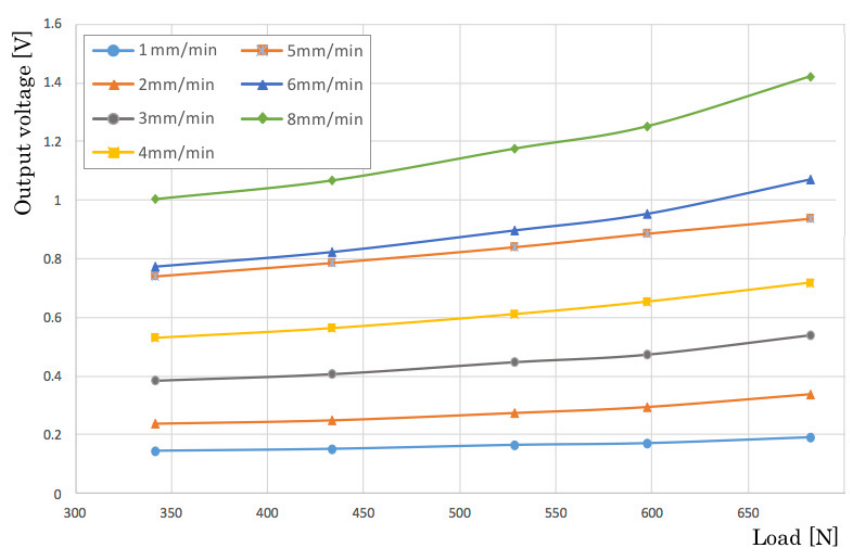
Figure 6. Relation between output voltage and load